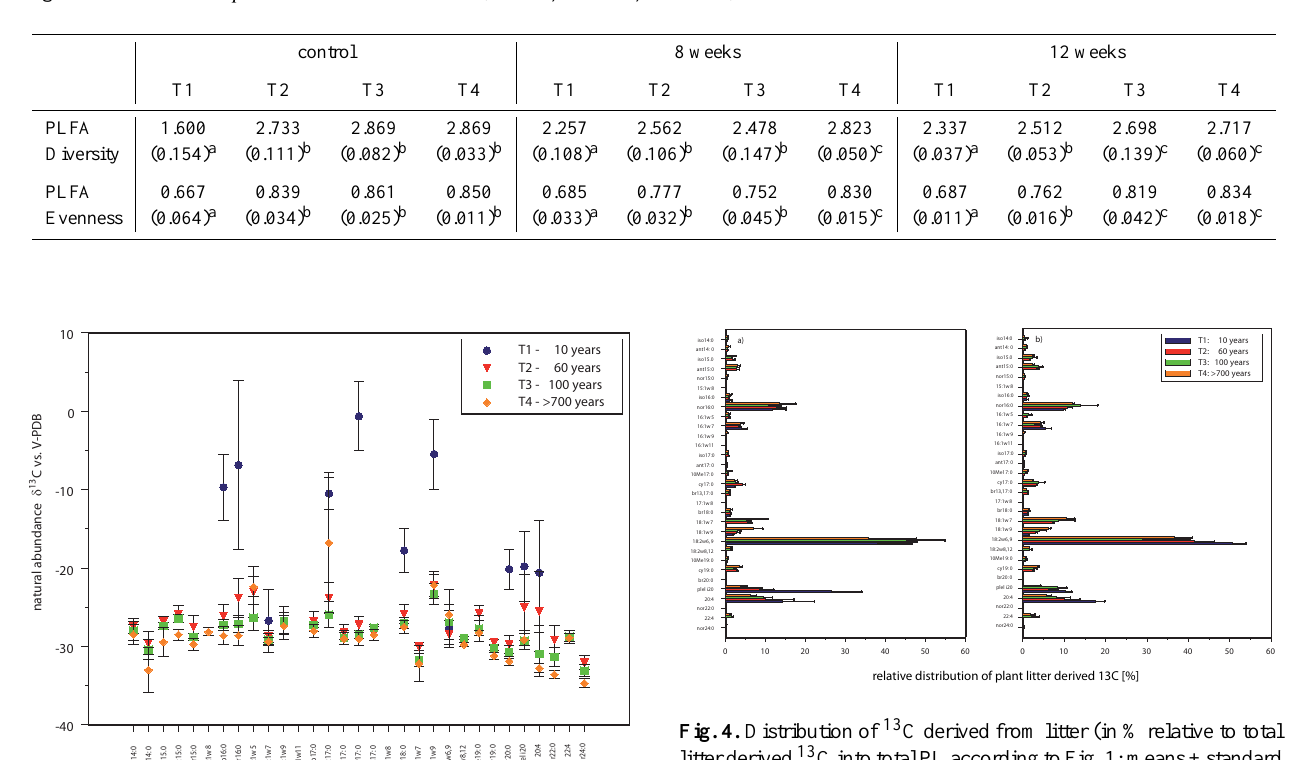
Table 3. Diversity and Evenness of the PLFA pattern (based on Shannon indices) in soil samples at T1–T4 after 8 weeks and 12 weeks of litter application, as well as without litter (control). Values are illustrated as means ( n = 5 ± standard deviation). Letters (a, b, c) indicate significant differences p < 0 . 05 within treatments (control, 8 weeks, 12 weeks).